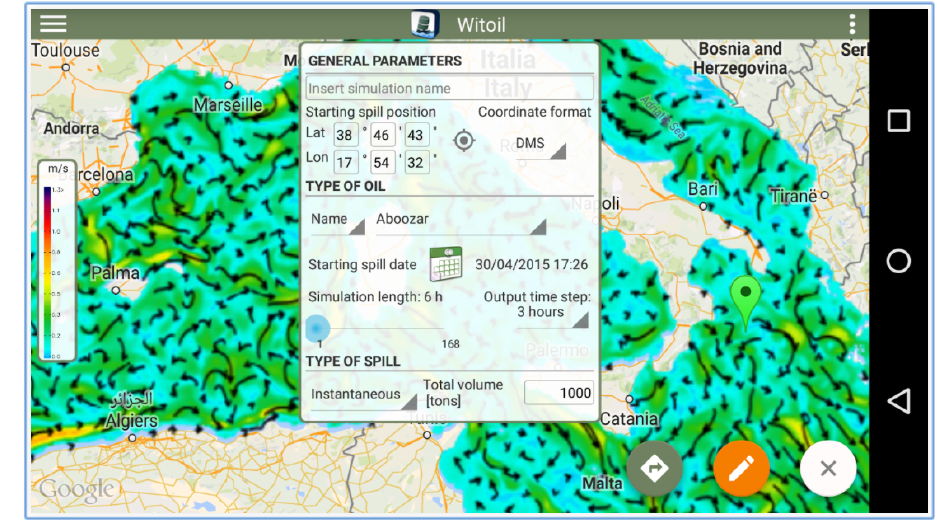
Figure 12. General view of the WITOIL application for